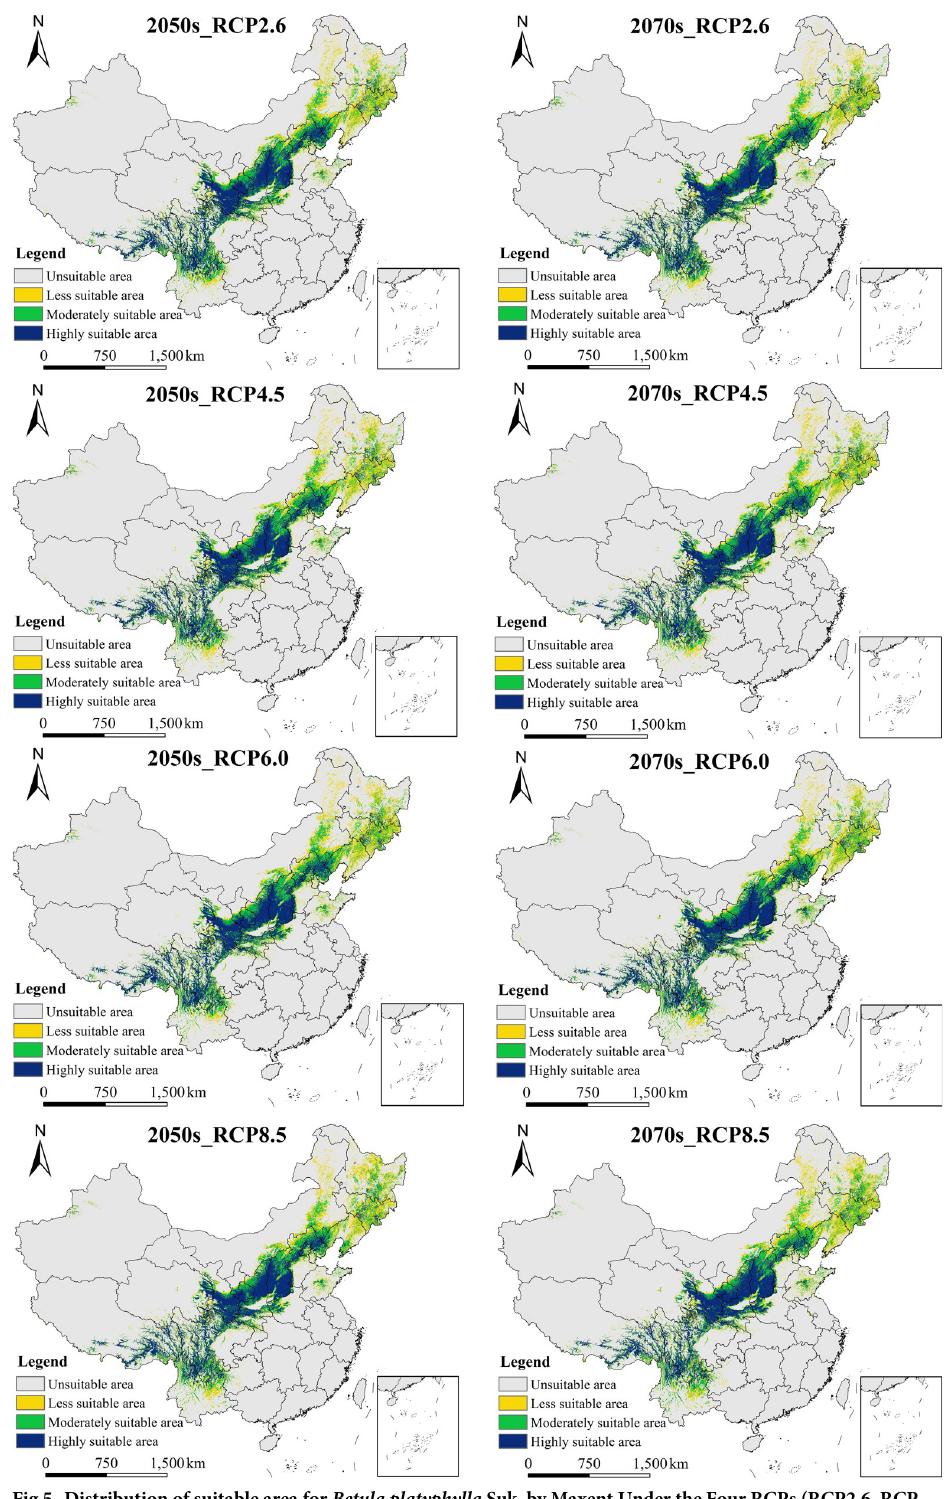
Fig 5. Distribution of suitable area for Betula platyphylla Suk. by Maxent Under the Four RCPs (RCP2.6, RCP 4.5, RCP 6.0, and RCP 8.5) in the Two Periods (the 2050s and 2070s). (When presence probability is < 0.2932, unsuitable area; When presence probability is 0.2932–0.40, less suitable area; When presence probability is 0.40–0.60, moderately suitable area; And when presence probability is > 0.60, highly suitable area). The boundary was obtained